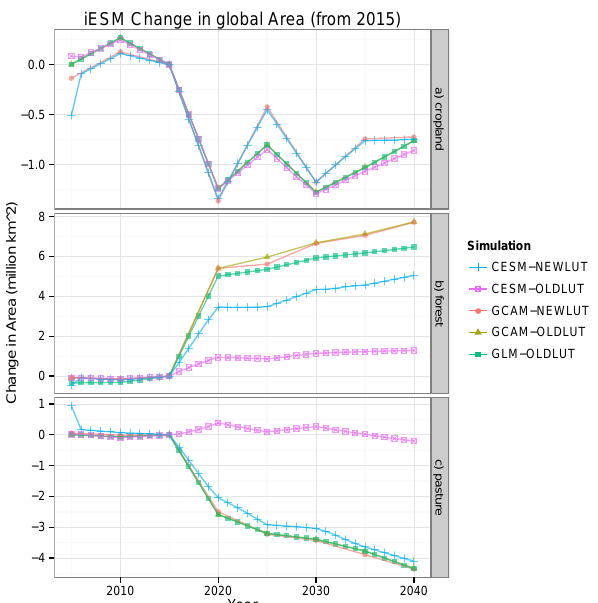
Figure 5. Projected global forest, pasture, grass, and shrub areas for the CMIP5 RCP4.5 scenario, in million km 2 .